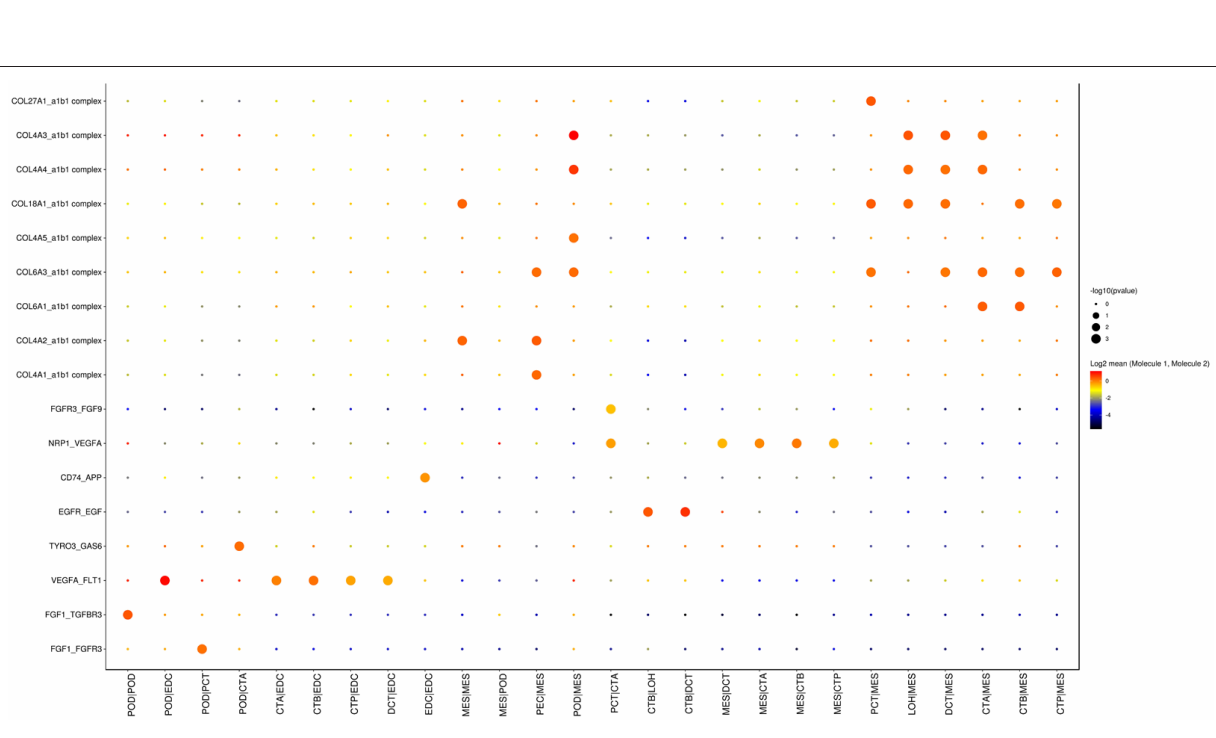
Frontiers in Medicine |